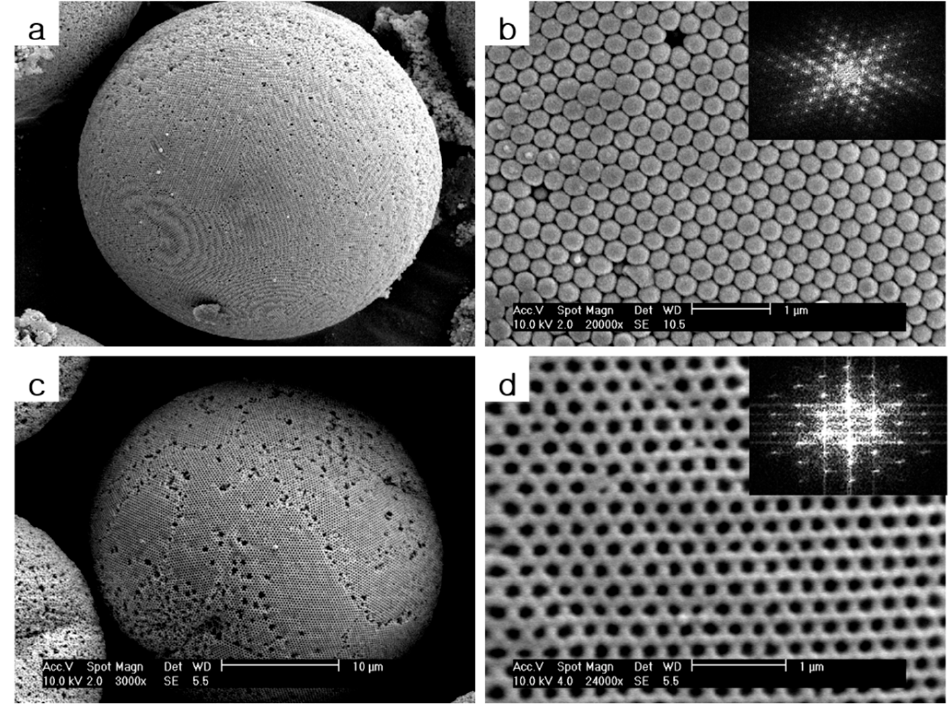
Figure 3. ( a , b ) SEM images of spherical opal composite structures consisting of PS / HEMA nanoparticles and titania nanoparticles. ( c , d ) SEM images of spherical titania inverse opal structure. Inset shows the fast Fourier transform (FTT) of the SEM images.